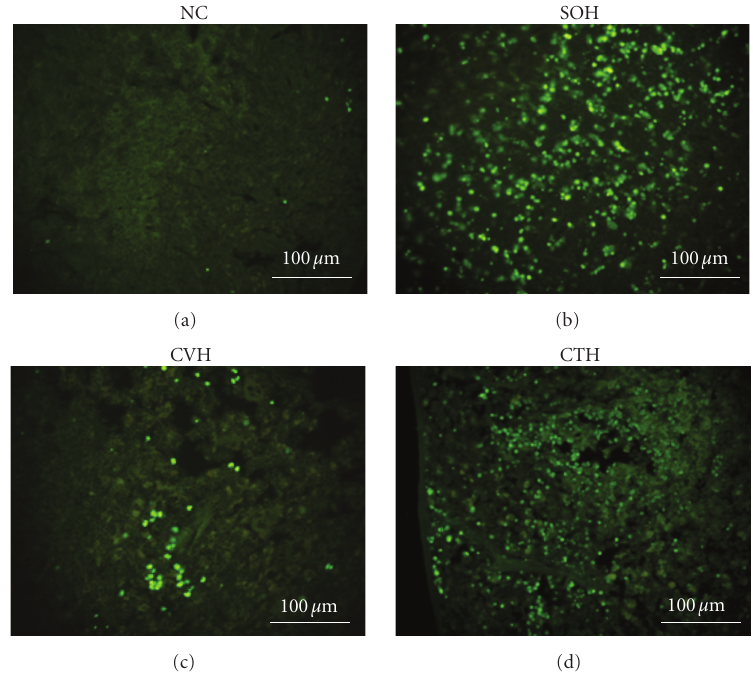
Figure 6: Photomicrographs of TUNEL staining of the spleen for an NC mouse, a SOH mouse, a CVH mouse, and a CTH mouse.